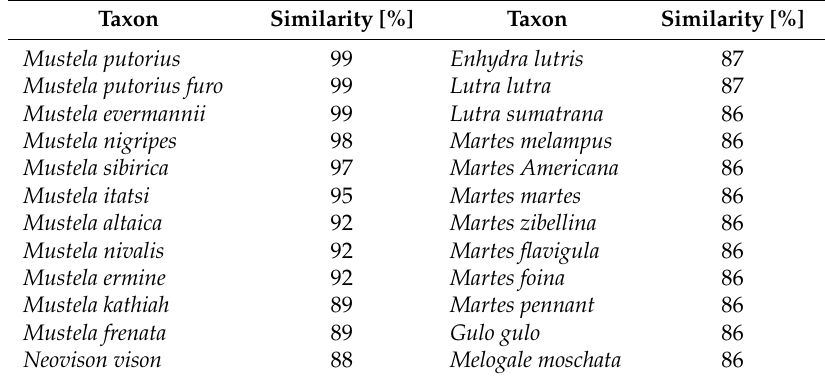
Mustela kathiah 89 Martes pennant 86 Mustela frenata 89 Gulo gulo 86 Neovison vison 88 Melogale moschata